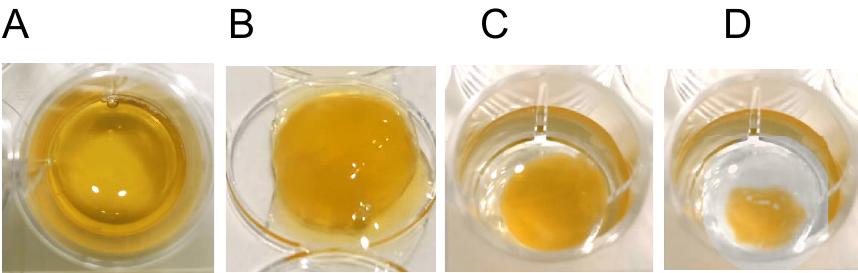
Figure 3. Osteogenic differentiation of DPSC in fibrin gel. ( A ) A plate with differentiated cells (FG-grown in fibrin gel; St- grown in standard conditions) from 3 donors. Cells are fixed and stained with Alizarin Red. The upper row of wells: 14 days of osteogenic differentiation in MSCgo™ Rapid Osteogenic Differentiation Medium; the bottom row of wells: cells grown in DMEM-low glucose medium. ( B ) The rate of first calcificates appearance in cells grown in gel and in standard conditions. Y-axis: the days after the start of osteogenic induction. ( C ) To quantify calcificates, Alizarin Red bound to calcificates was dissolved, and the optical absorbance was measured as described by Bogdanova et al., 2018 [26]. The value obtained for the control cell was set as 100% (Y-axis). The values in the panels ( B ), ( C ) are given as M ± m (means and standard errors).